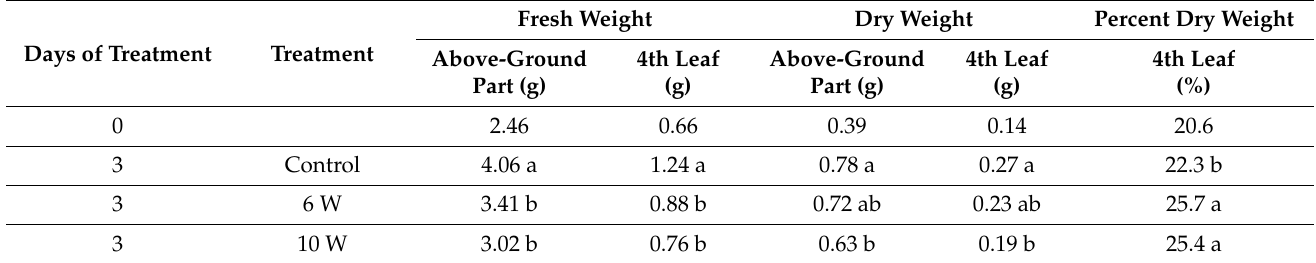
Table 1. Effect of UV irradiation on the growth of the above-ground parts and 4th leaf of red perilla after 3 d of UV-B treatment (experiment 1). Plants were exposed to UV-B irradiation at 0 (control), 6 (6 W), and 10 W m − 2 (10 W).